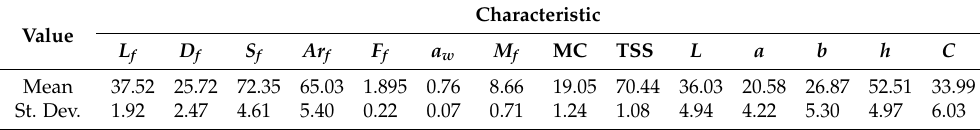
Table 2. Mean values and standard deviations (St. Dev) of length ( L f , mm), diameter ( D f , mm), fruit sphericity ( S f ), fruit aspect ratio ( Ar f ), firmness ( F f , N cm − 2 ), water activity ( a w ), mass ( M f , g), moisture content (MC, %), total soluble solids (TSS, Brix), lightness ( L ), redness ( a ), yellowness ( b ), chroma ( C ), and hue angle ( h , degree) of dates immediately after